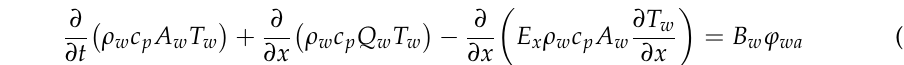
Table 1. The main parameters used in the water temperature model. Parameter Interpretation Parameter Interpretation ρ w mass density of water c p specific heat capacity of water T w water temperature Q w flow discharge of water flow cross-sectional area of the A w channel width of water surface channel B w cross-section the ratio of the length of the water surface of the cross-section N i covered by ice cover to the width of the water surface of the same cross-section